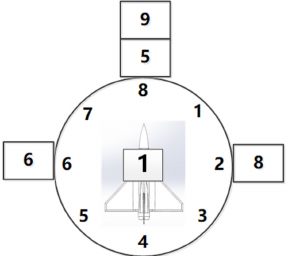
Figure 16. Reference for the UAV at square 1.